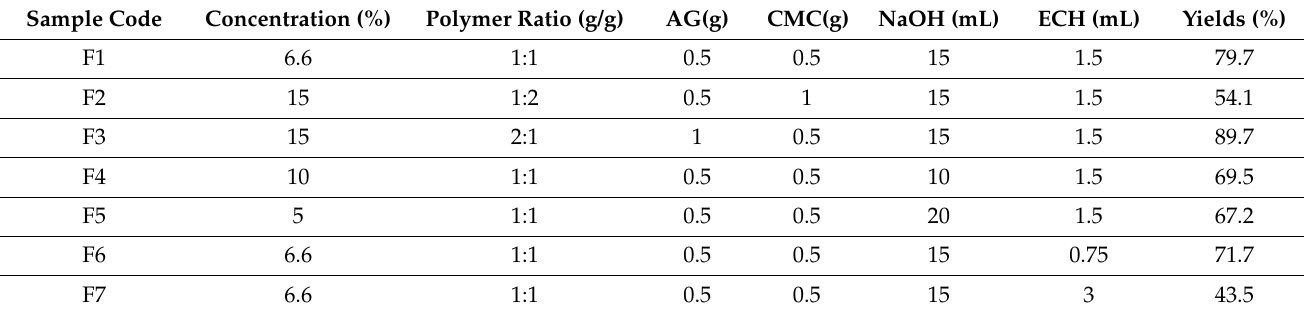
Table 1. The initial reactants composition for hydrogel preparation and